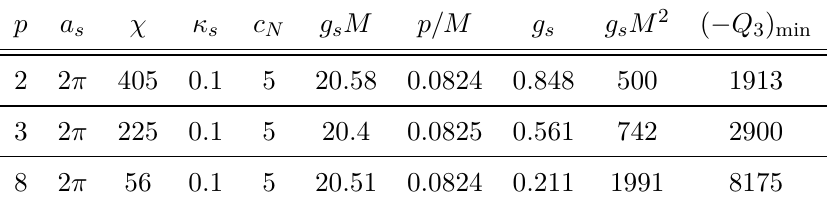
Table 1. Minimal value of the required tadpole ( − Q 3 ) min for the minimum of V tot to occur in the controlled regime for different p .